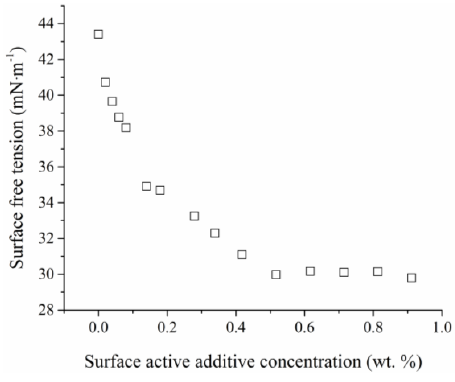
Figure 2. Surface tension of ACR dispersion vs. surface active additive (Agent 1) concentration.